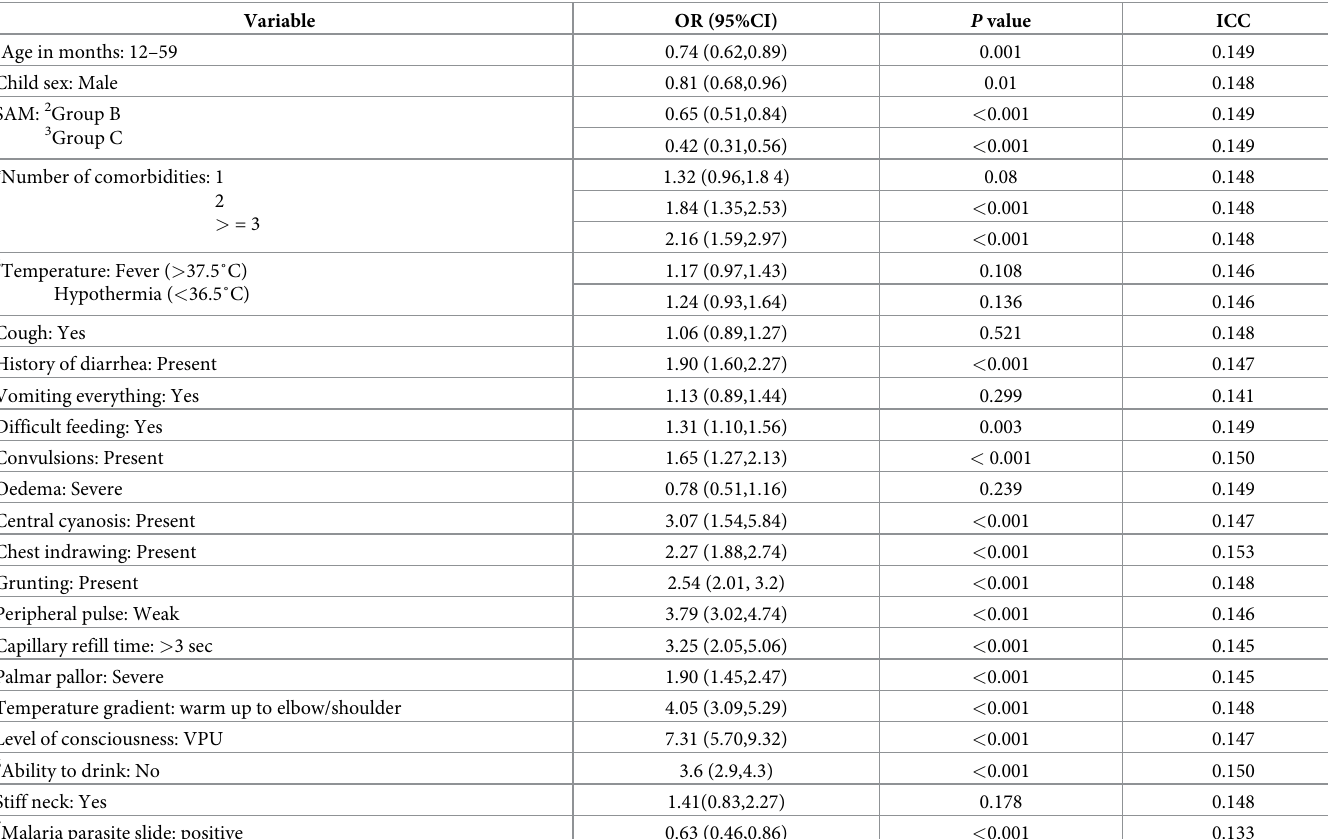
Table 4. Complete cases univariable analysis for association with mortality among children admitted with severe acute malnutrition (all groups A, B and C) between April 2014 and November 2016. Variable OR (95%CI)